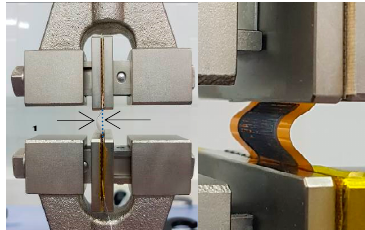
Figure 2. Universal testing machine grips holding the sensor. d = maximum deflection distance.